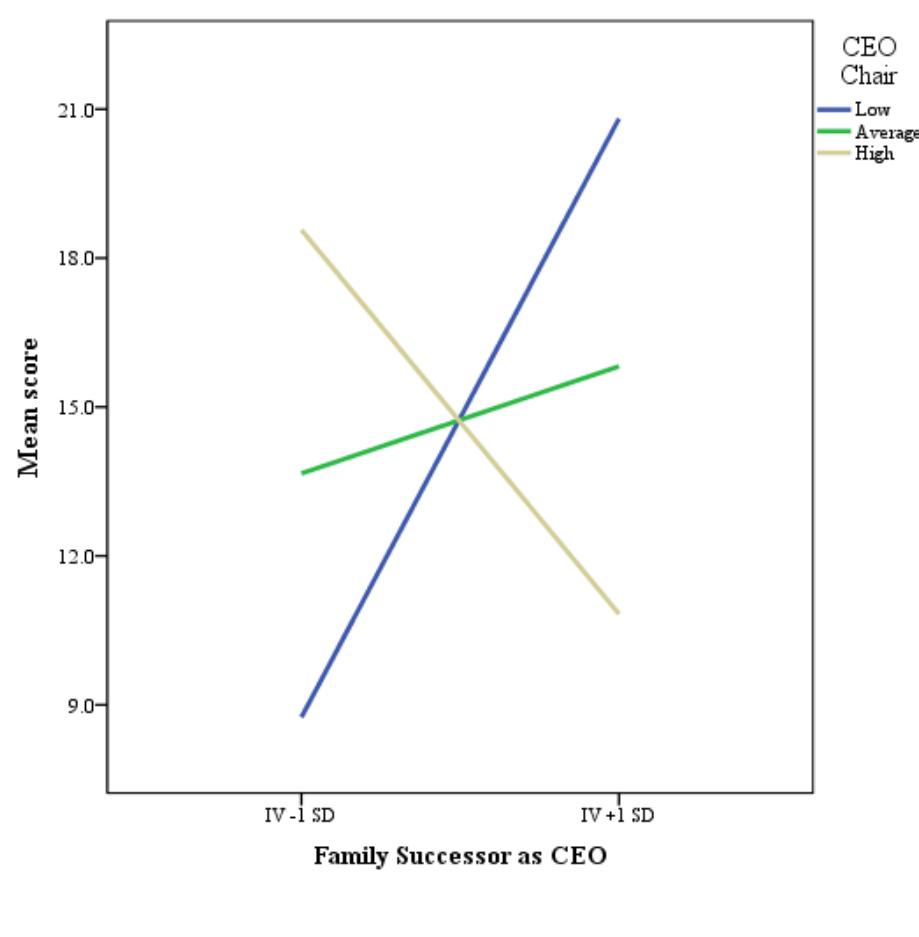
Figure 1. Interaction Plot: Family Successor and CEO